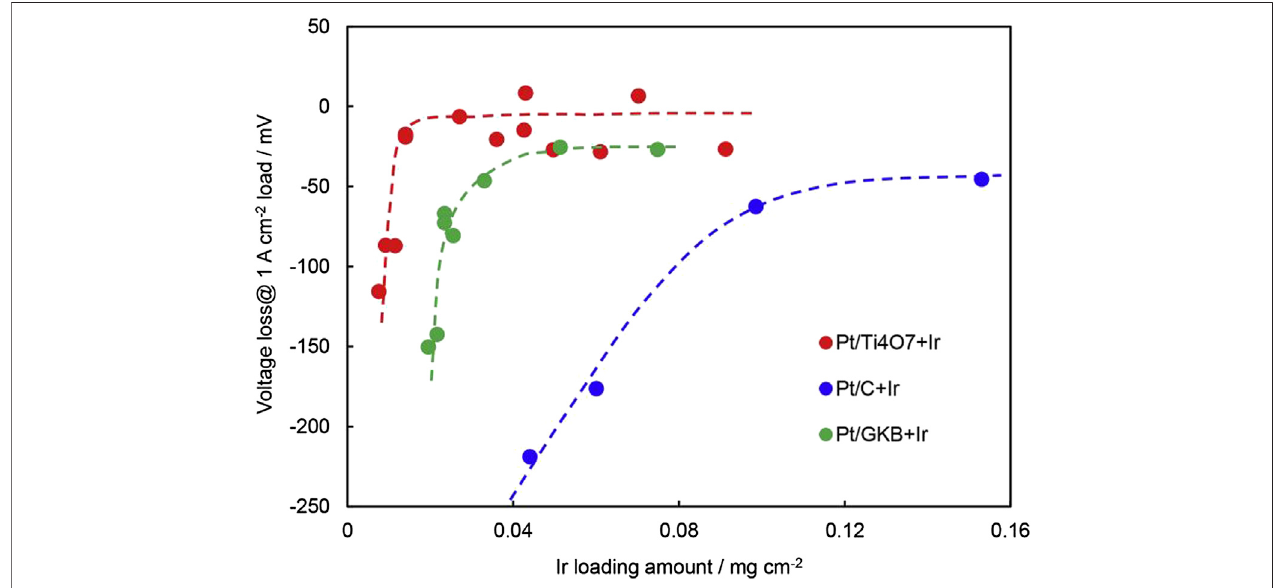
FIGURE 5 | Voltage loss of MEA with various RTAs at 1 A/cm 2 after the reversal test for approximately 2 h (H 2 and O 2 were humidi fi ed and the fl ow is 100 ml/min each, ambient pressure, 80 ° C). Reproduced with permission (Ioroi and Yasuda, 2020). Copyright 2020, Elsevier.